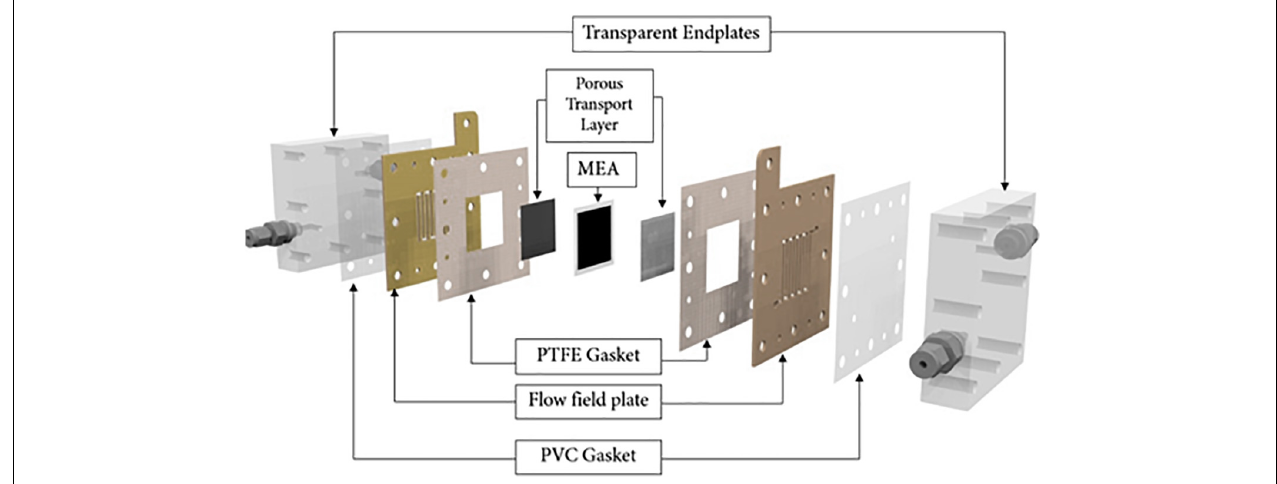
FIGURE 1 | Schematic of the PEMWE cell used for the study.